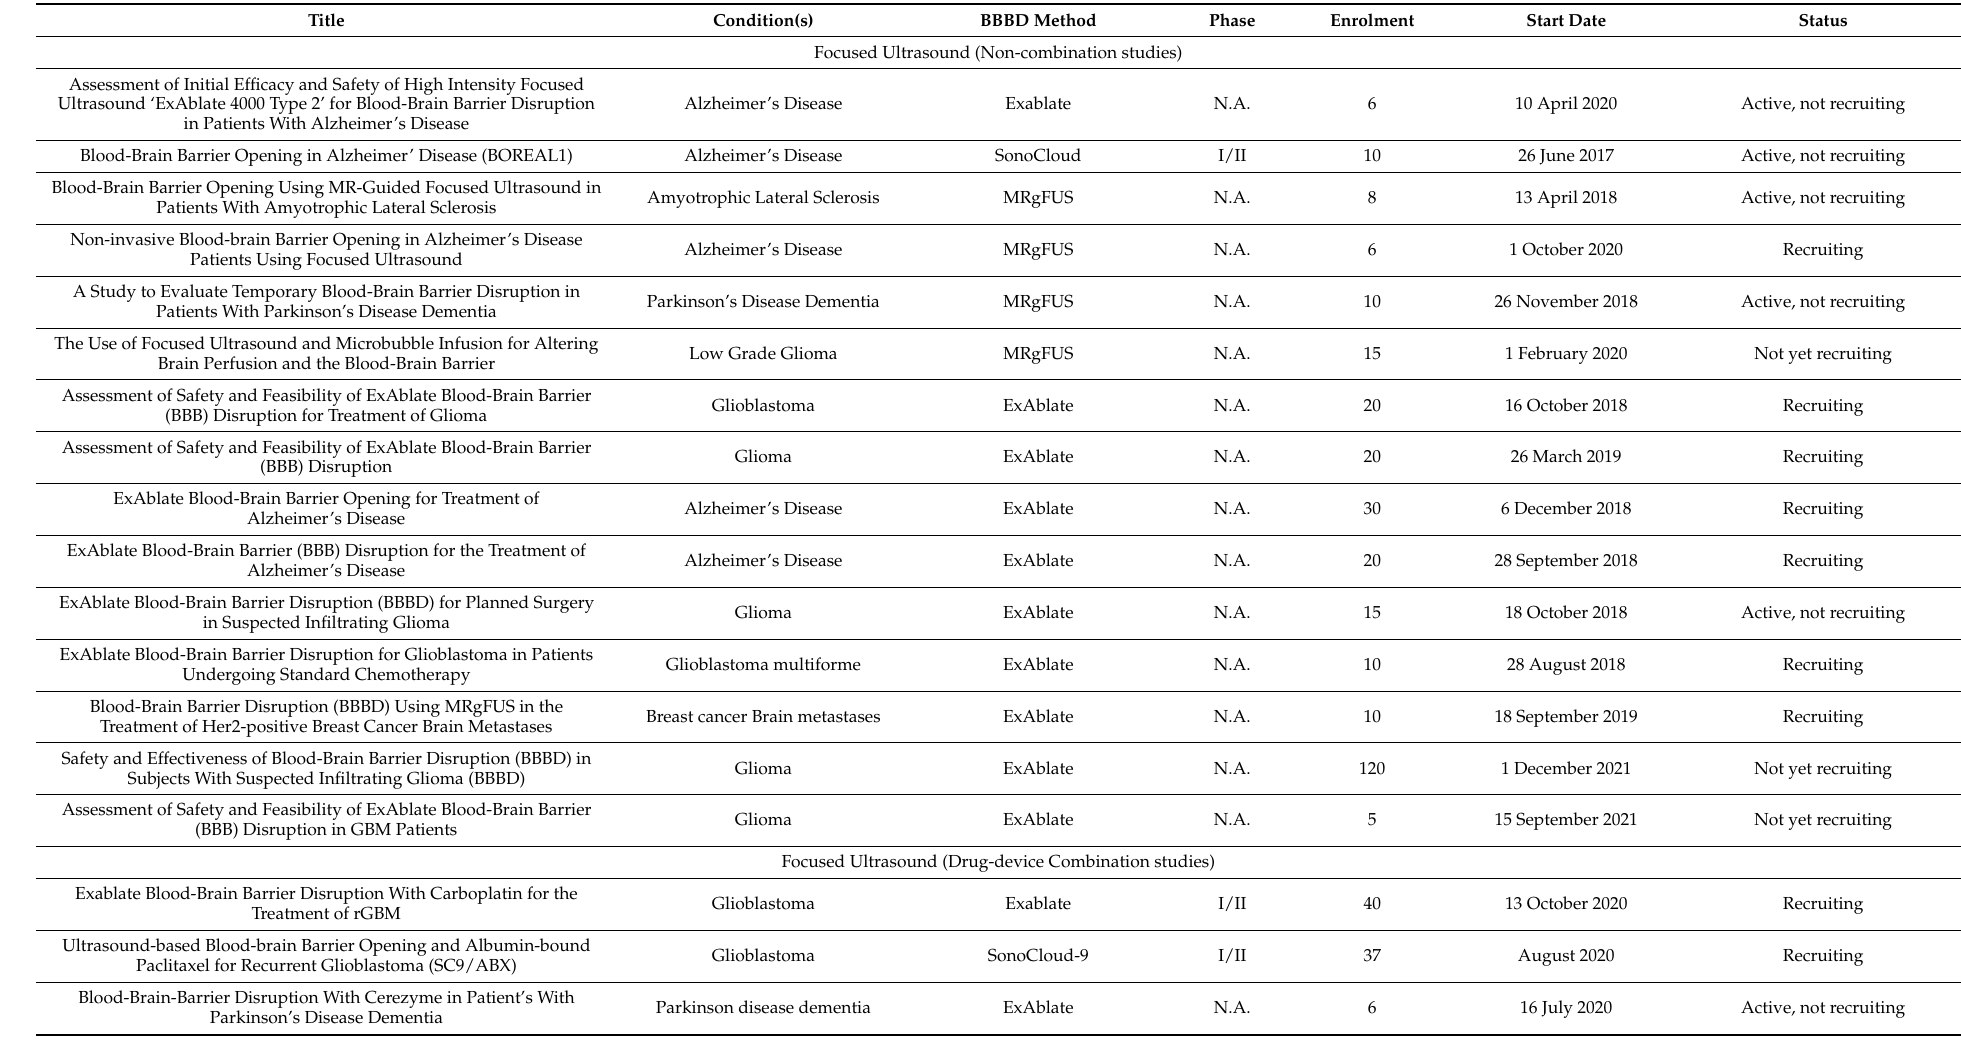
Table 5. Active NIH Clinical Trials in Therapeutic Blood–Brain Barrier Disruption